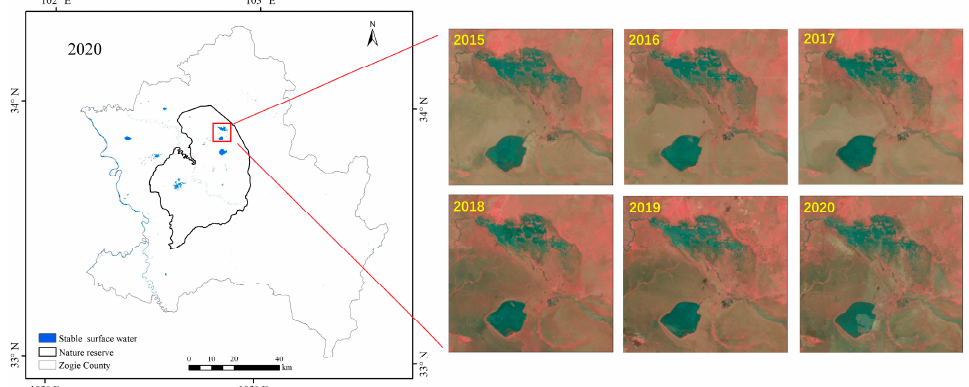
Figure 7. Spatial distributions of water area in Zoige county in 2020 and Landsat remote-sensing images of the Huahu Lake.